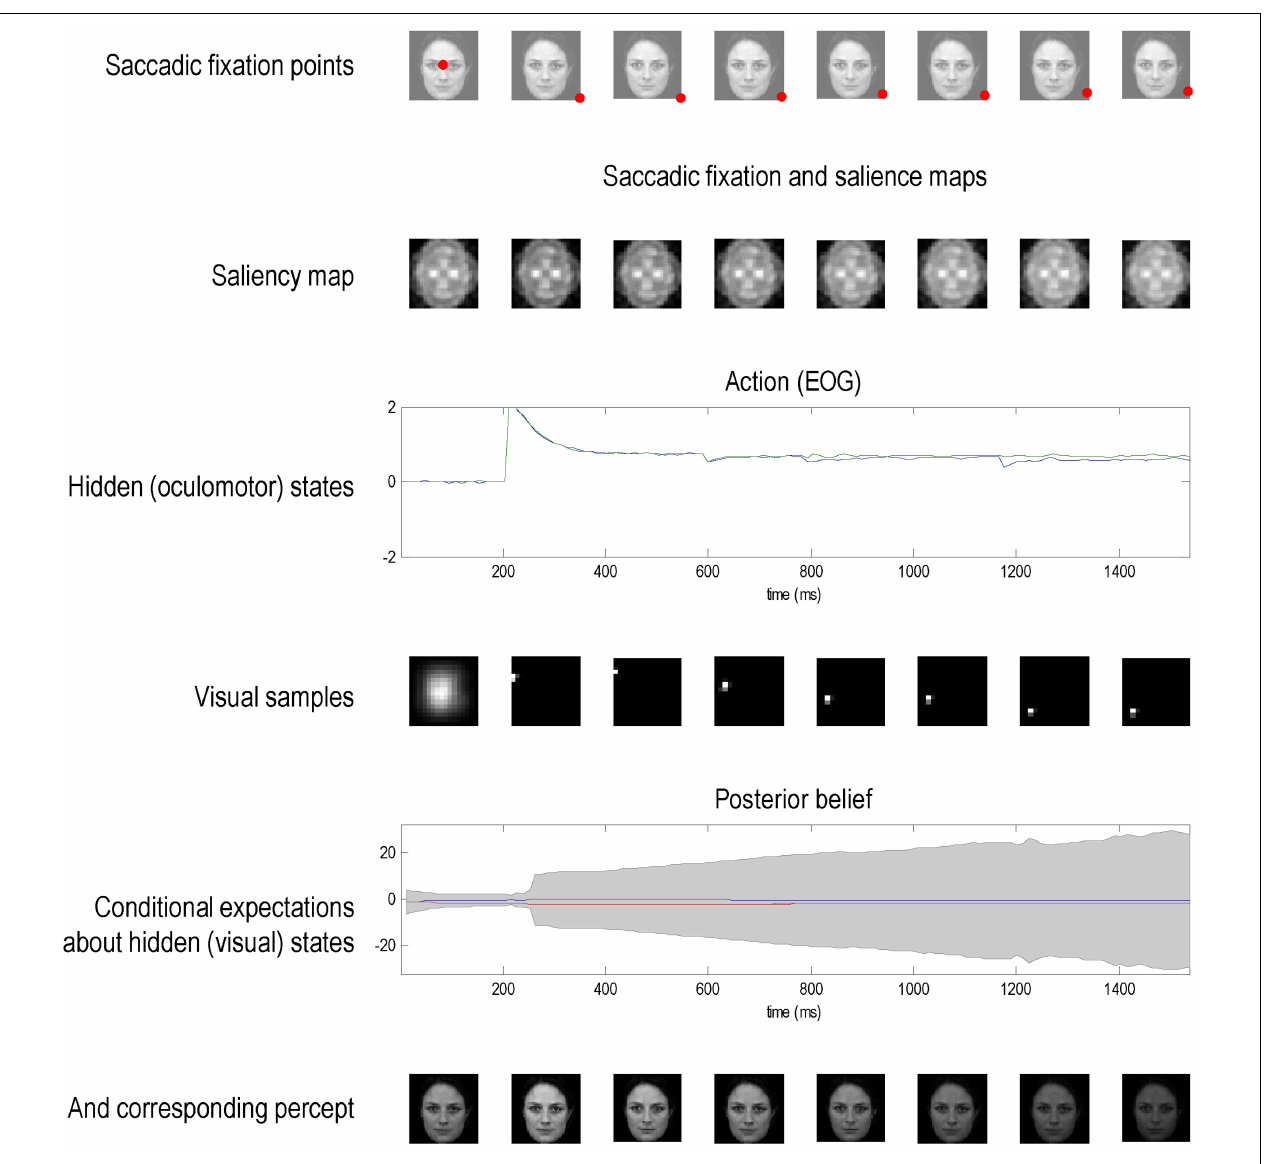
previously).This results in a progressive increase in uncertainty about the stimulus; as reflected in the convergence of posterior expectations about the three hypotheses and an increase in conditional uncertainty (penultimate row). As time progresses, the percept fades (lower row) and the agent is effectively sequestered from its sensorium. Note here how the salience map remains largely unchanged and encodes a composite salience of all (three) prior hypotheses about states of the world causing visual